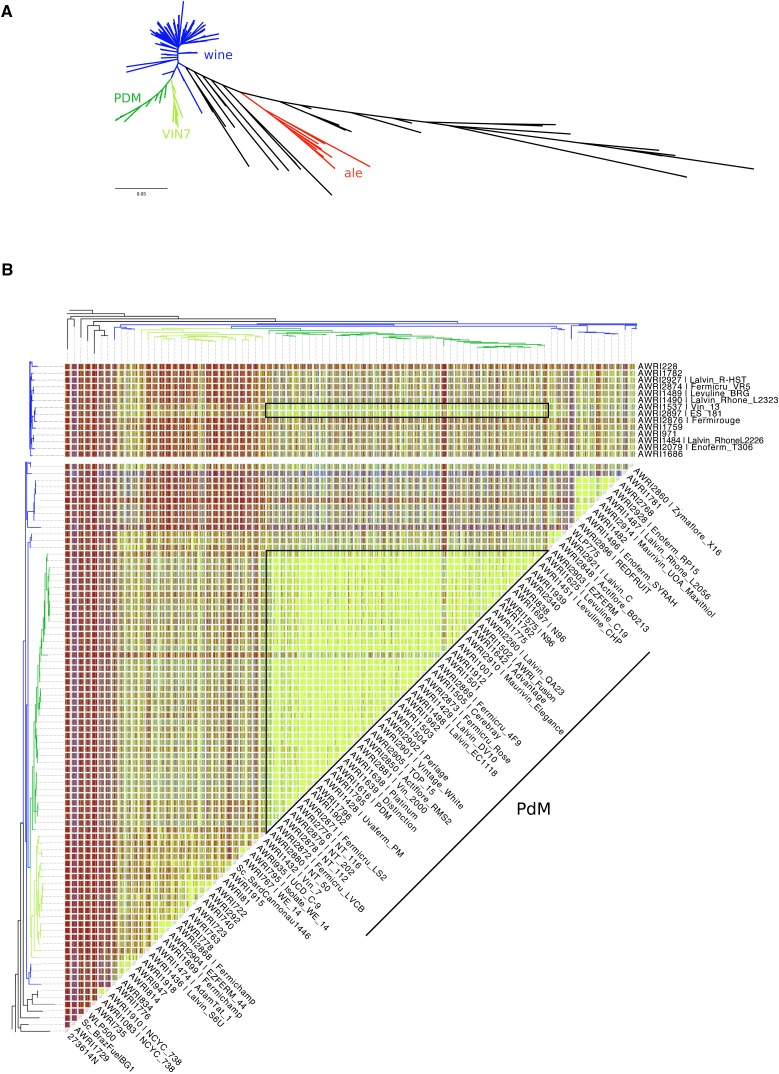
Genetic analysis of wine yeast strains. (A) An unrooted maximum-likelihood phylogeny of 236 strains of S. cerevisiae. Strains isolated from, or used in, ale brewing (red), or winemaking (blue and green) are highlighted. Dark- and light-green have been used to designate strains belonging to two main subclades within the wine yeasts. (B) Identity-by-state (IBS) analysis of the PdM clade and related strains (black boxes). SNPs were compared pairwise, across the collection of strains, with each variant position scored according to the pattern of nucleotide conservation. IBS state 2 (IBS2) represents identical diploid genotypes (e.g., AA:AA, AT:AT), IBS1 loci share one allele (e.g., AA:AT; AC:AT), while IBS0 loci are completely different (e.g., AA:TT; AT:CG). Results were then smoothed using a 50-kb sliding window with a 25-kb step, with individual windows categorized according to four genomic states IBS2 (< 5% IBS1, <1% IBS0; green), IBS2|1 (≥ 5% IBS1, < 1% IBS0; blue), IBS2|1|0 (≥ 5% IBS1, ≥ 1% IBS0; red), and IBS2|0 (< 5% IBS1, ≥ 1% IBS0; red).